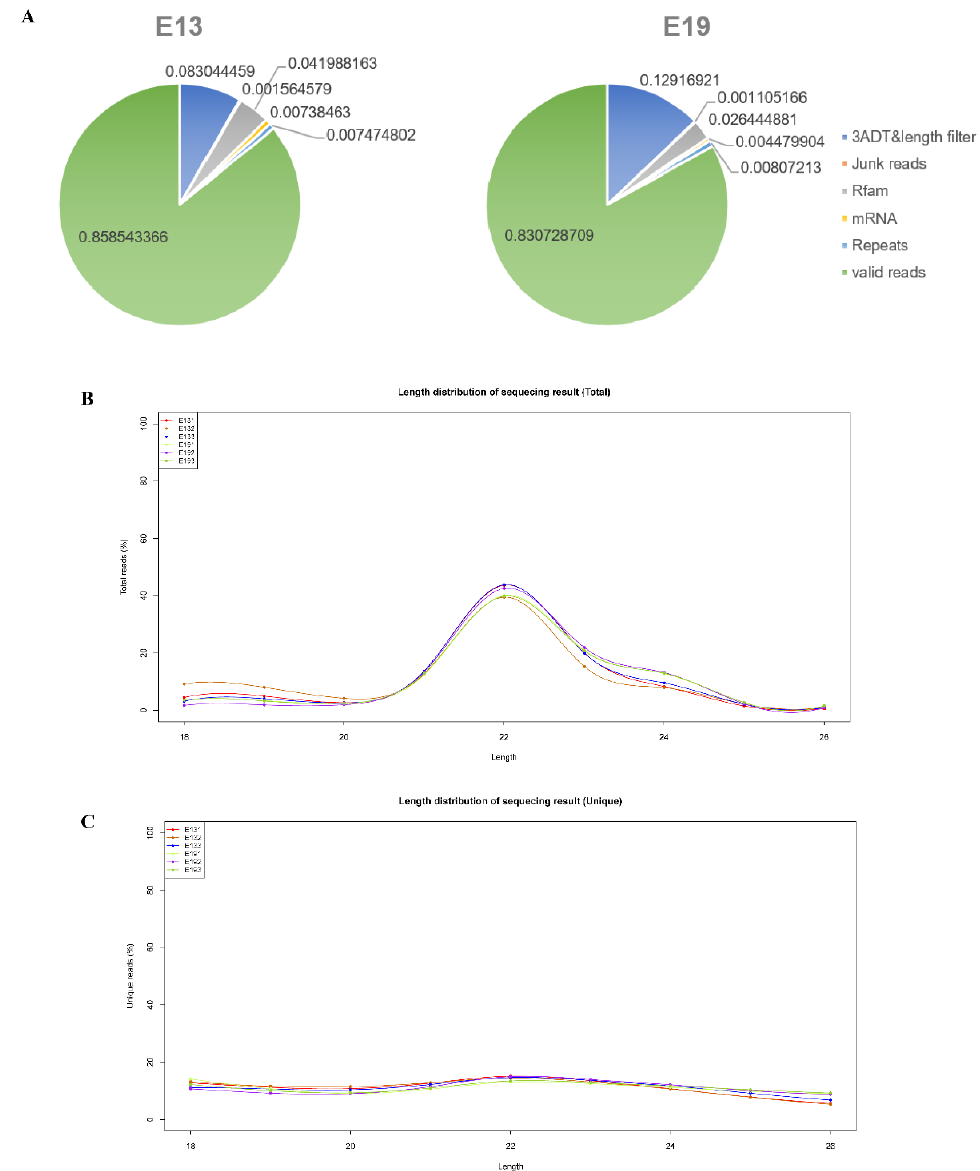
Figure 1. Overview of sequencing data. ( A ) Pie chart distribution annotation of the small RNAs at embryonic day 13 (E13) and E19; ( B ) Length distribution percentage of small RNA sequences in embryonic duck breast muscle. All validated reads of 18–26 nucleotides (nt) for E13 and E19 were assessed for size distribution; ( C ) Length distribution percentage of unique reads in embryonic duck breast muscle. The validated unique reads of 18–26 nt were counted for size distribution.